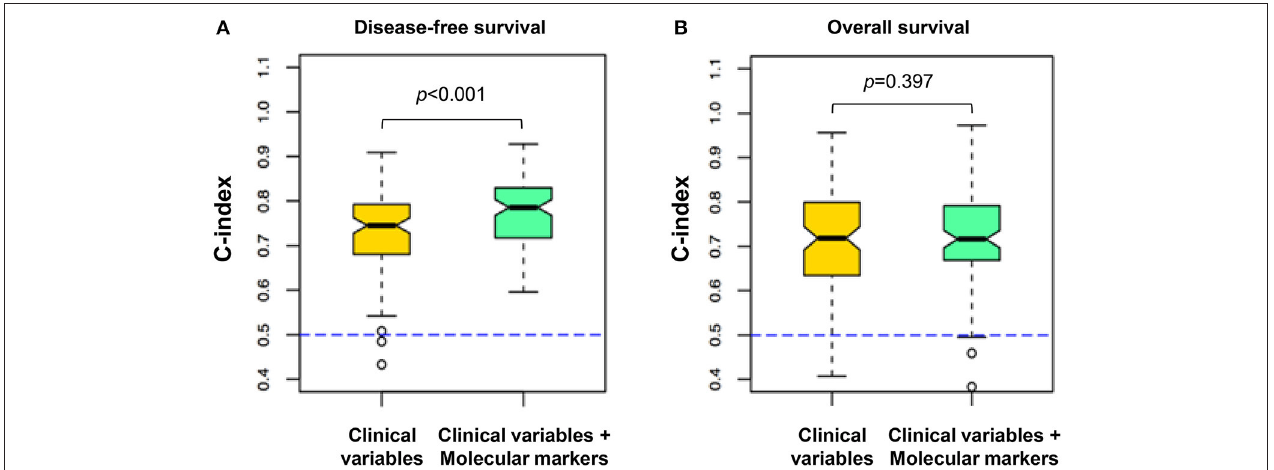
FIGURE 5 | Comparison of survival predictive power between the clinical variables and the combined clinical and molecular data. The plots indicate the distribution of C-indexes from 100 rounds of cross-validation. The yellow box highlights the model built from the clinical variables, and the green box highlights the models integrating the molecular variables of PAUF-related proteins and the clinical variables. (A) Using the combined clinical and molecular markers (median C-index 0.79) to predict recurrence yielded improved predictive power compared with the clinical variable model (median C-index 0.74; p < 0.001). (B) The combined clinical/molecular-variable model showed similar performance compared with the clinical variable model in predicting death ( p = 0.397). The dashed line indicates the C-index equivalent to a random guess (C-index = 0.5). A C-index of 1 indicates perfect